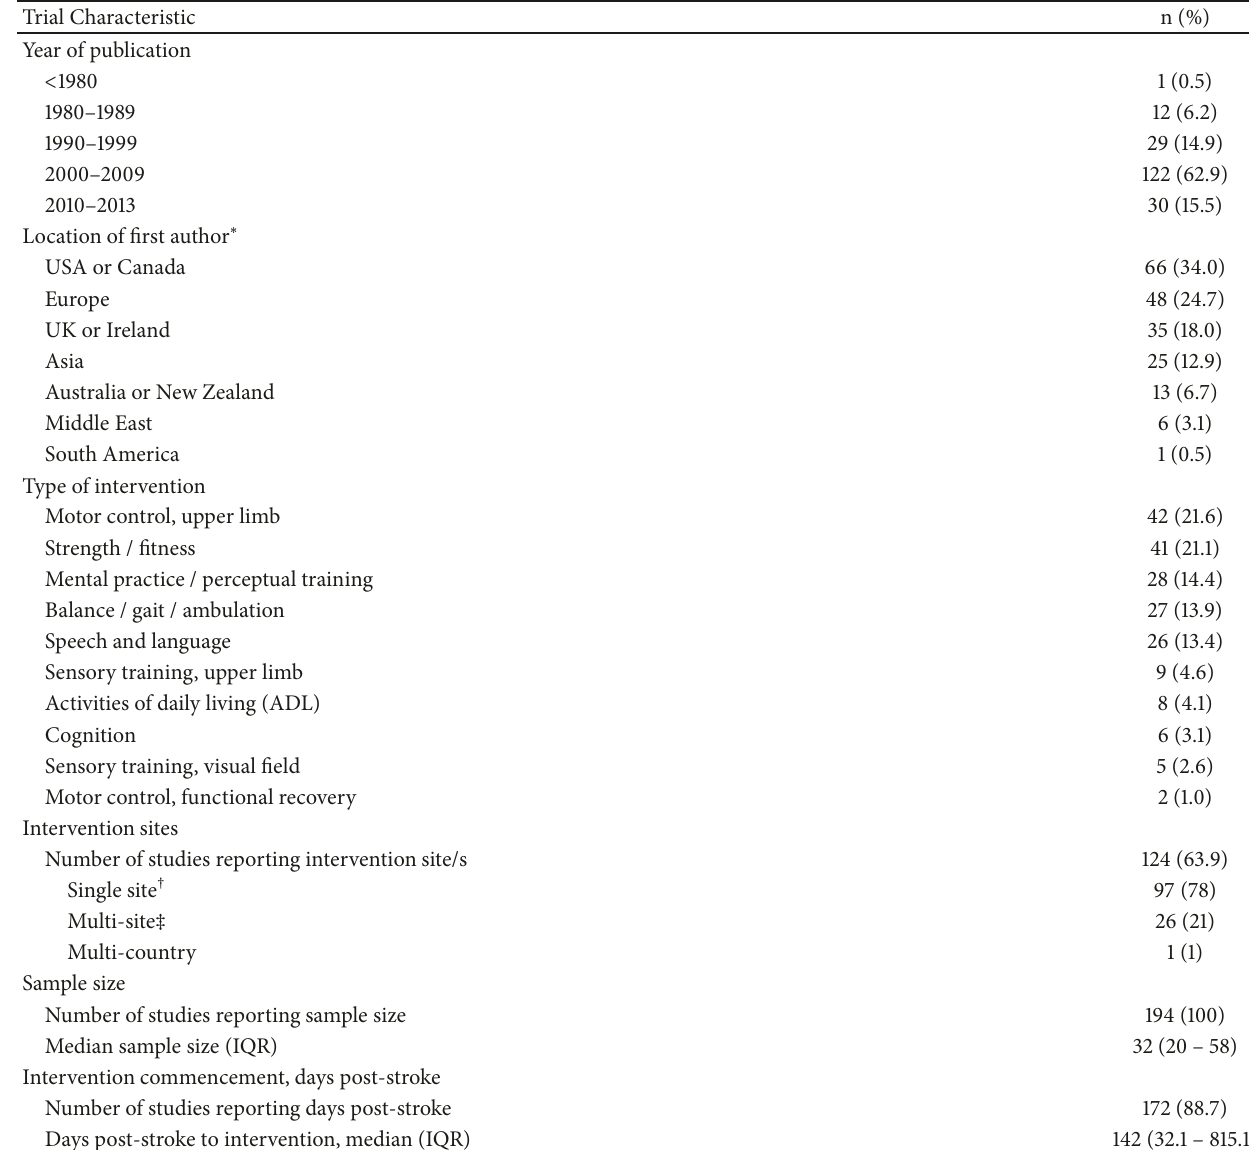
Table 2: Characteristics of 194 included